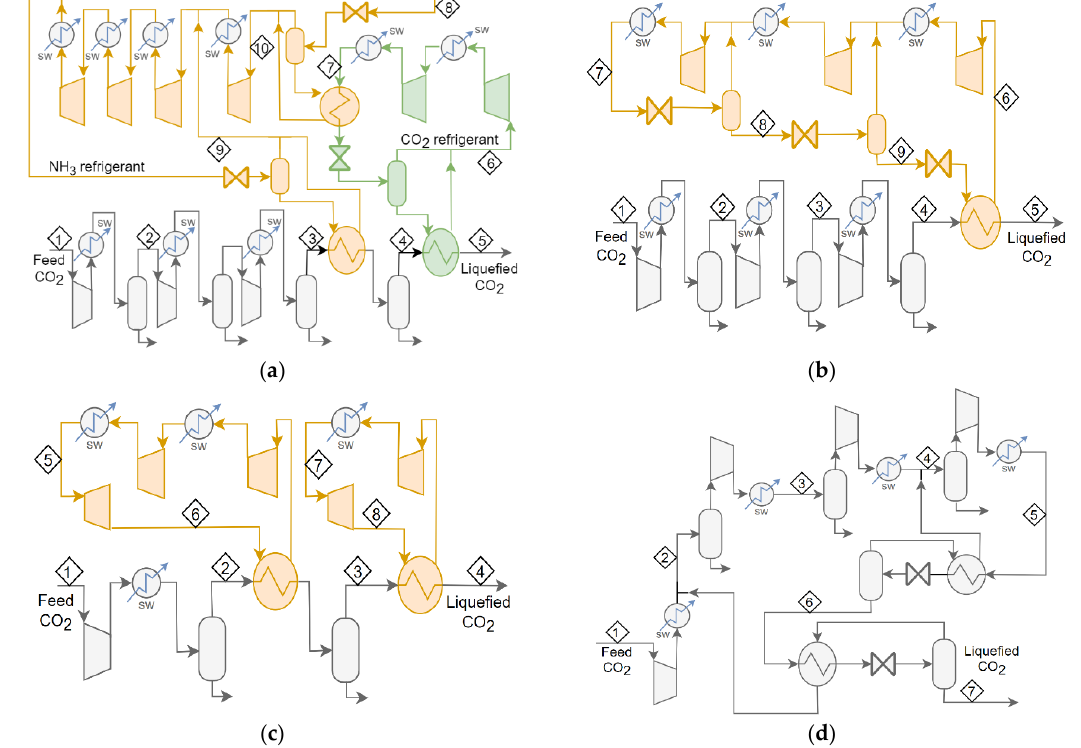
Figure 1. Process flow diagrams for the “base” cases for the CO 2 liquefaction schemes; ( a ) shows Case 1, ( b ) Case 2, ( c ) Case 3, and ( d ) Case 4. Table 1. Summary of modelling parameters.